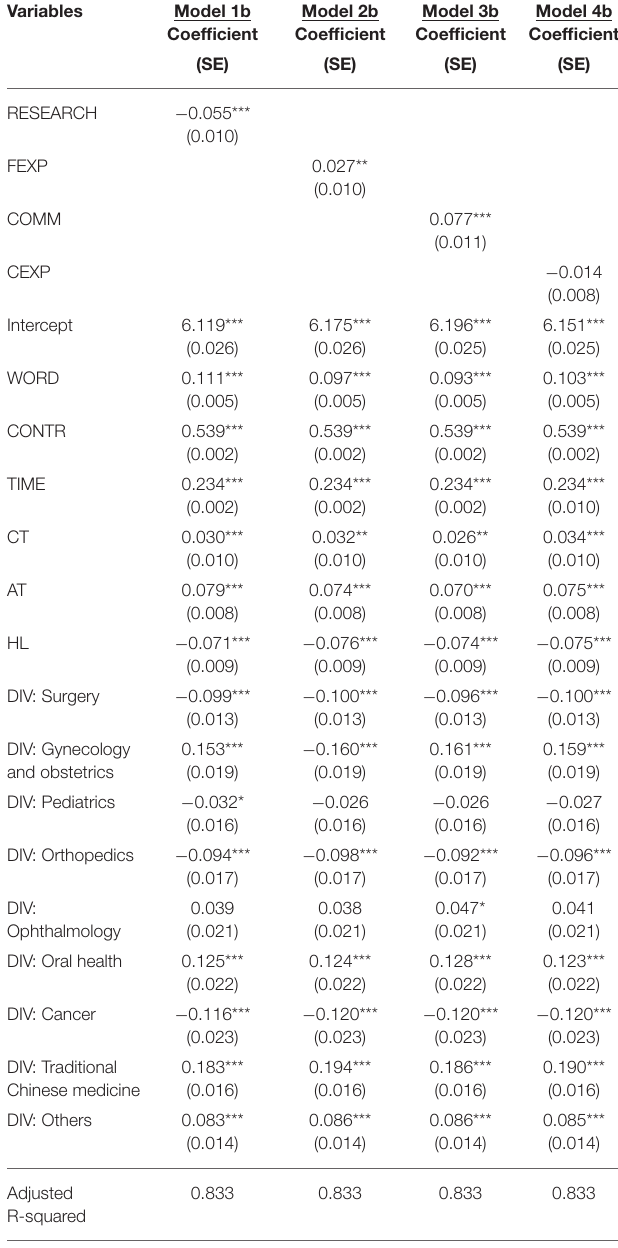
TABLE 5 | Results for the topic model applied to